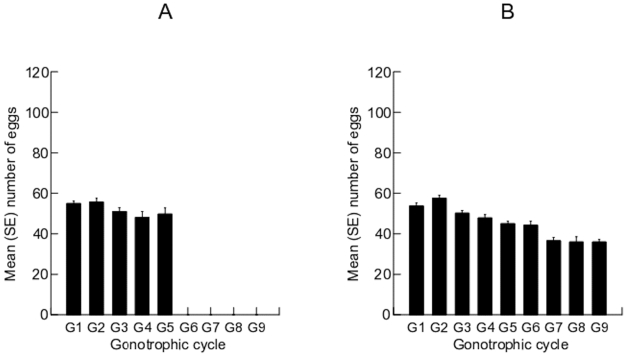
Numbers of eggs (mean ± SE) laid by FWMs (A) d5FWMs (B) of Ae. albopictus.